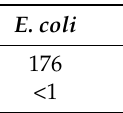
Table 4. Antimicrobial results after performing tests against reduction in total and faecal coliform and E. coli in control conditions and treatment using CXTi synthesised in this